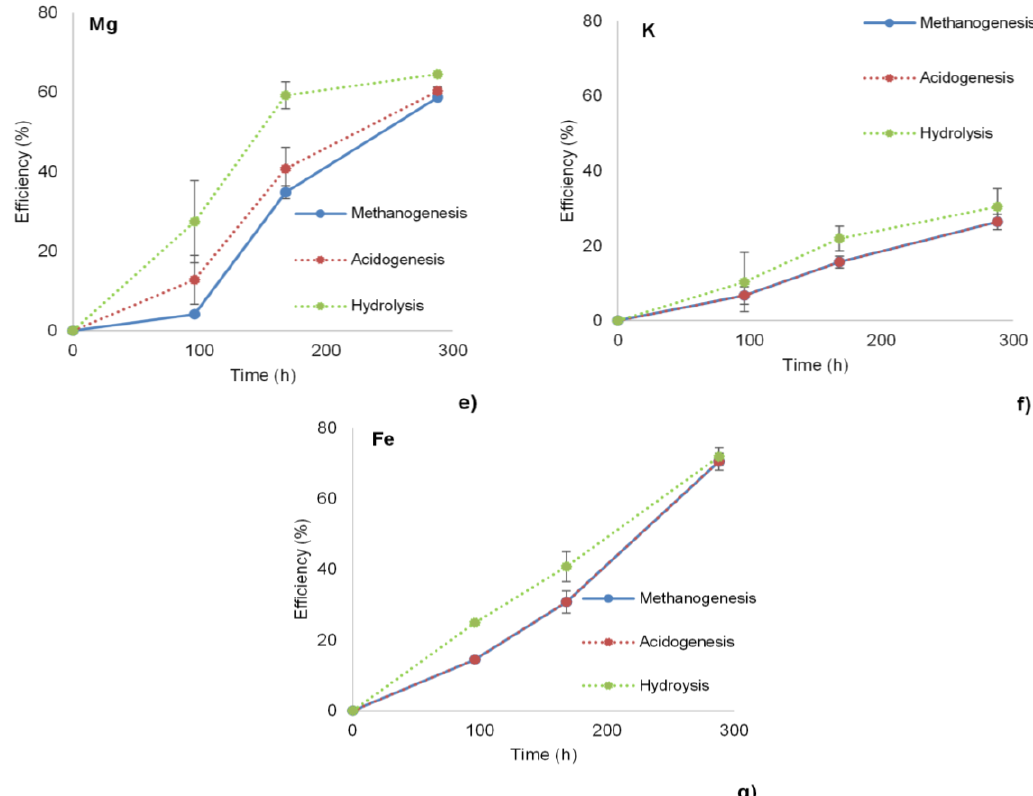
Figure 1. Salt addition experiments, namely efficiency (%) of methanogenesis, acidogenesis and hydrolysis over time. Results of each experimental group is illustrated with; ( a ) positive control (C), ( b ) inhibition control (I), salt addition experiment group of; ( c ) calcium (Ca), ( d ) sodium (Na), ( e ) magnesium (Mg), ( f ) potassium (K) and ( g ) iron (Fe)salts. (Error bars show the standard deviation between measurements, n =